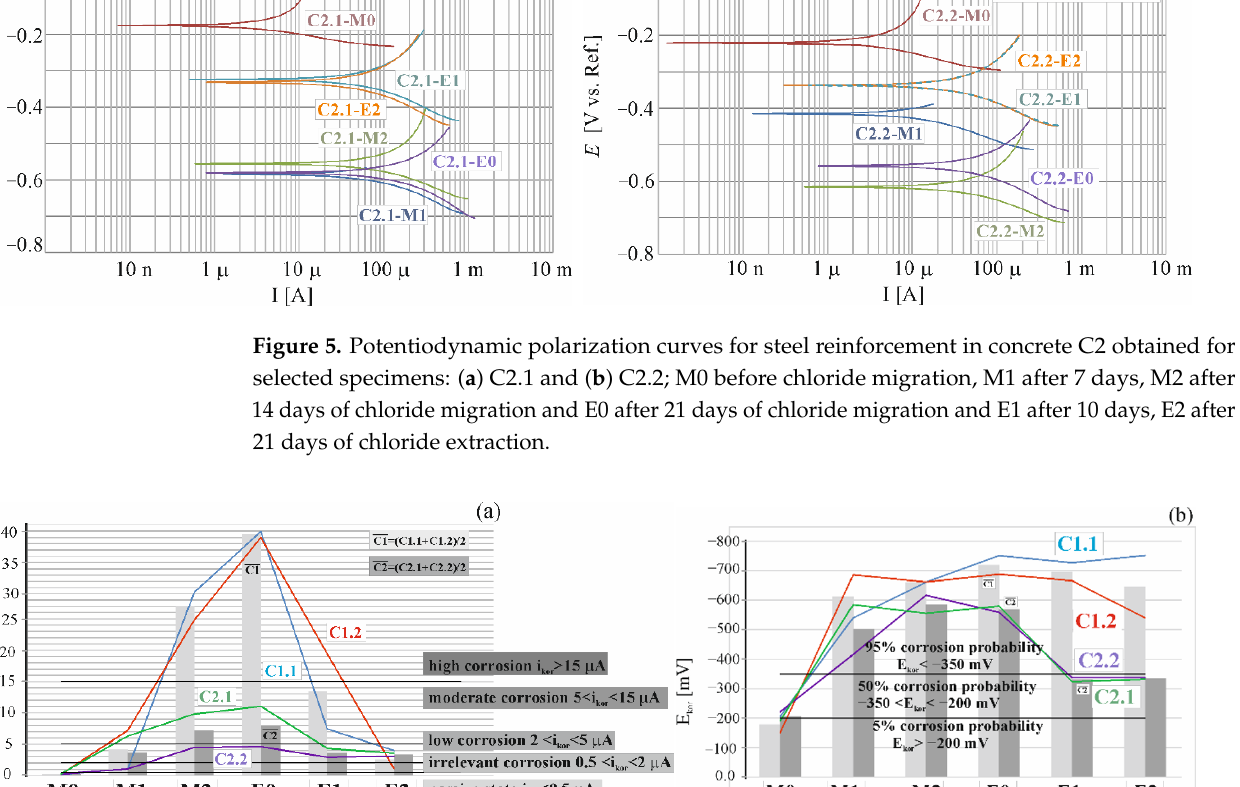
Figure 6. Distribution: ( a ) of corrosion current densities and ( b ) corrosion potential obtained selected specimen C1.1, C1.2, C2.1 and C2.2: M0 — before chloride migration), M1 — after 7 days, M2 — after 14 days of migration, E0 — after 21 days of migration, E1 — after 10 days of chloride extraction and E2 — after 21 days of extraction.